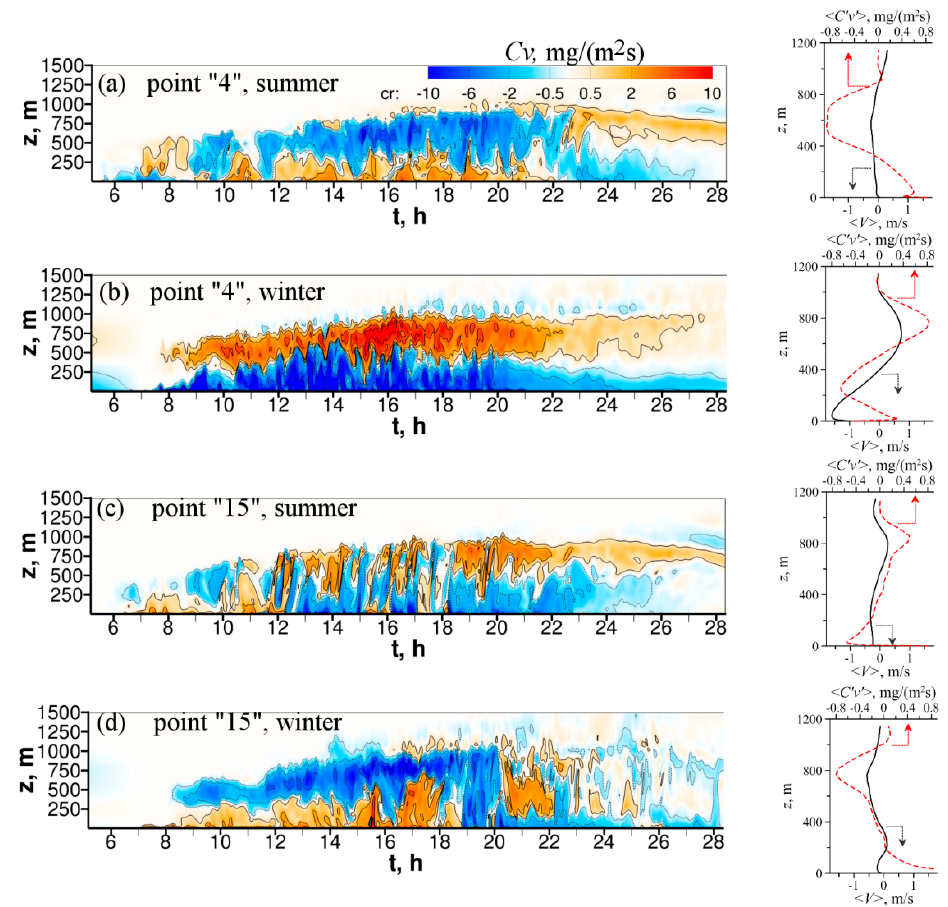
Figure 15. Temporal evolution of horizontal (in the direction across the river) advection intensity ( Cv ) and daily-averaged profiles of horizontal velocity (in the direction of the river) and horizontal turbulent concentration flux < c ’ v ’> (right) for several points (shown in Figure 1). ( a , c ) Summer case; ( b,d ) Winter case.